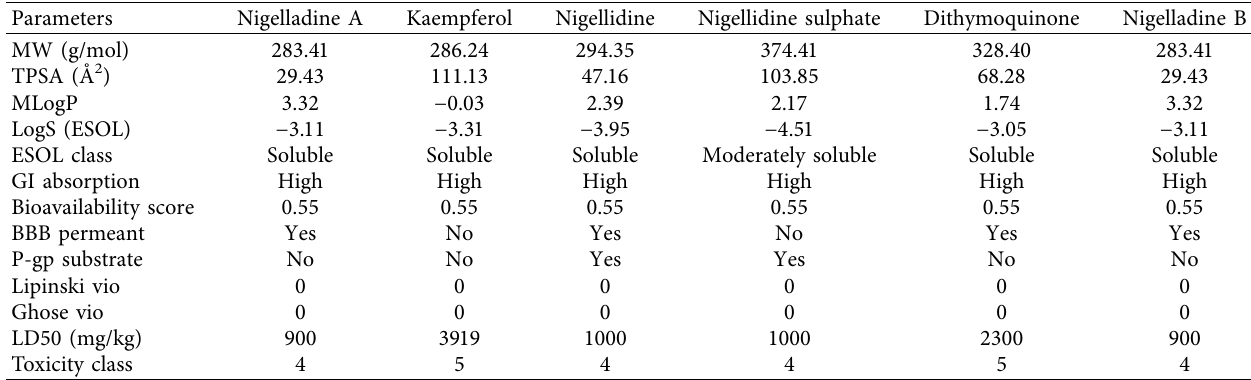
Table 2: Te physicochemical, pharmacokinetic, and pharmacodynamic properties of the molecules with the top 6 docking scores retrieved from SwissADME and Protox-II.